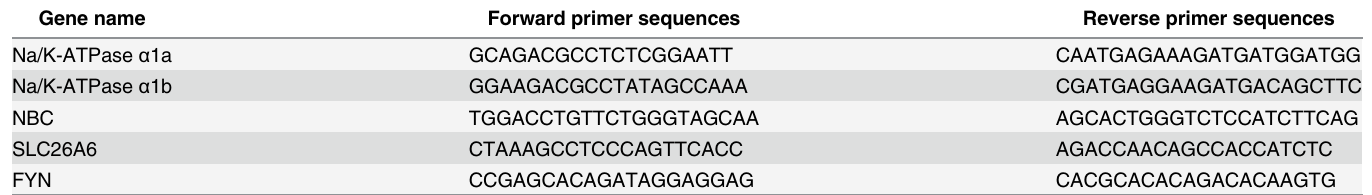
Table 1. Primer pairs for real time quantitative